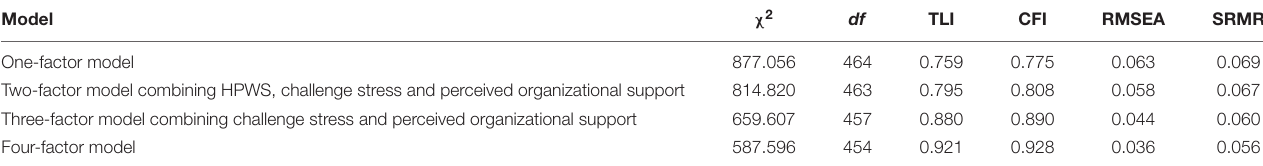
TABLE 1 | Results of confirmatory factor analysis.